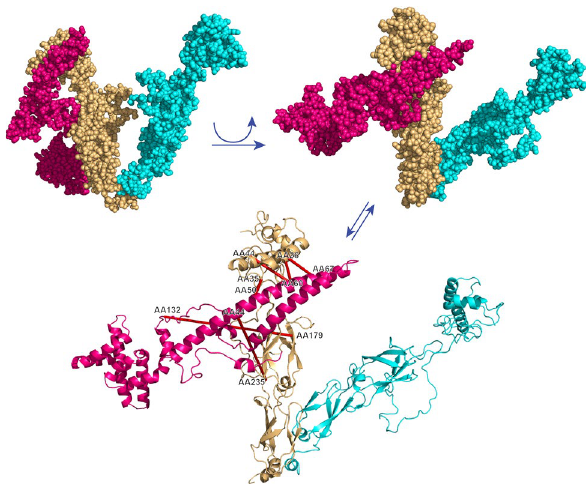
Figure 6. Homology model of the CDC-37·DNJ-13 complex. PDB structure 4J80 served as template for DNJ- 13, monomers highlighted in cyan and brown; CDC-37 was modeled after PDB structure 5FWL, highlighted in magenta. Arrows indicate a rotation of the model and/or a swap between visualizations as either space-filling or ribbon model. Crosslinks are depicted as red lines between the ribbon models. Homology models were generated in Chimera 1.13.1, docked with HADDOCK 2.4 and crosslinks were visualized in PyMOL